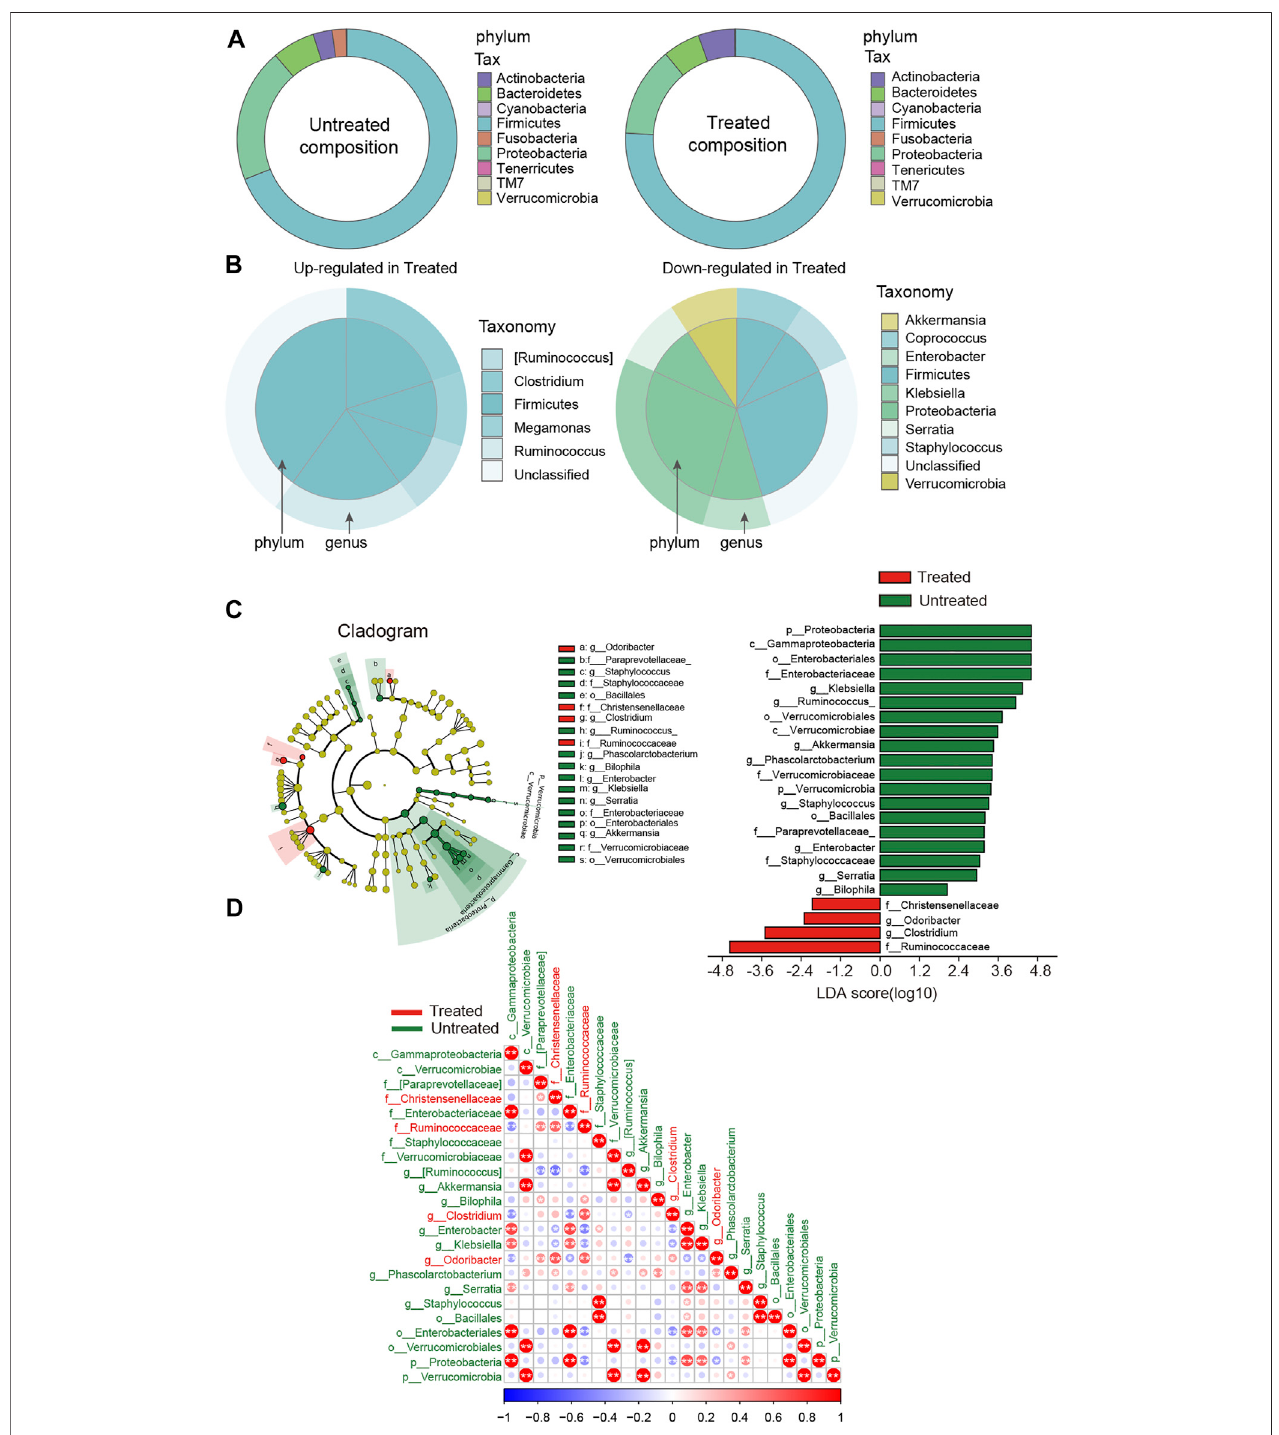
FIGURE2| DisparityingutmicrobialcompositioninthestoolsamplesbetweenuntreatedandACEI/ARB-treatedHTNpatients. (A) Piegraphshowingthebacterial proportion and composition of the overall nine phylum in untreated and treated groups. (B) As compared with the untreated group, the upregulated and downregulated genera and the corresponding phylum in the ACEI/ARB-treated group are shown in a pie chart, respectively. The outer circle represents a genus while the inner circle indicatesthephylumitderivesfrom. (C) LEfSecladogramandLDAscoreanalysisrevealeddifferencesintaxonomiccomposition,andthebacterialtaxasigni fi cantly enriched the treated (green) and untreated (red) groups. (D) Heat map describing the correlation between different taxonomic compositions. A negative correlation is shown inred and apositive correlation inblue. The bacteria enriched in thetreatedpatientsarelabeledwith red color, while those dominant in theuntreatedpatientsare labeled with green. *, p < 0.05; **, p < 0.01, Spearman ’ s correlation.